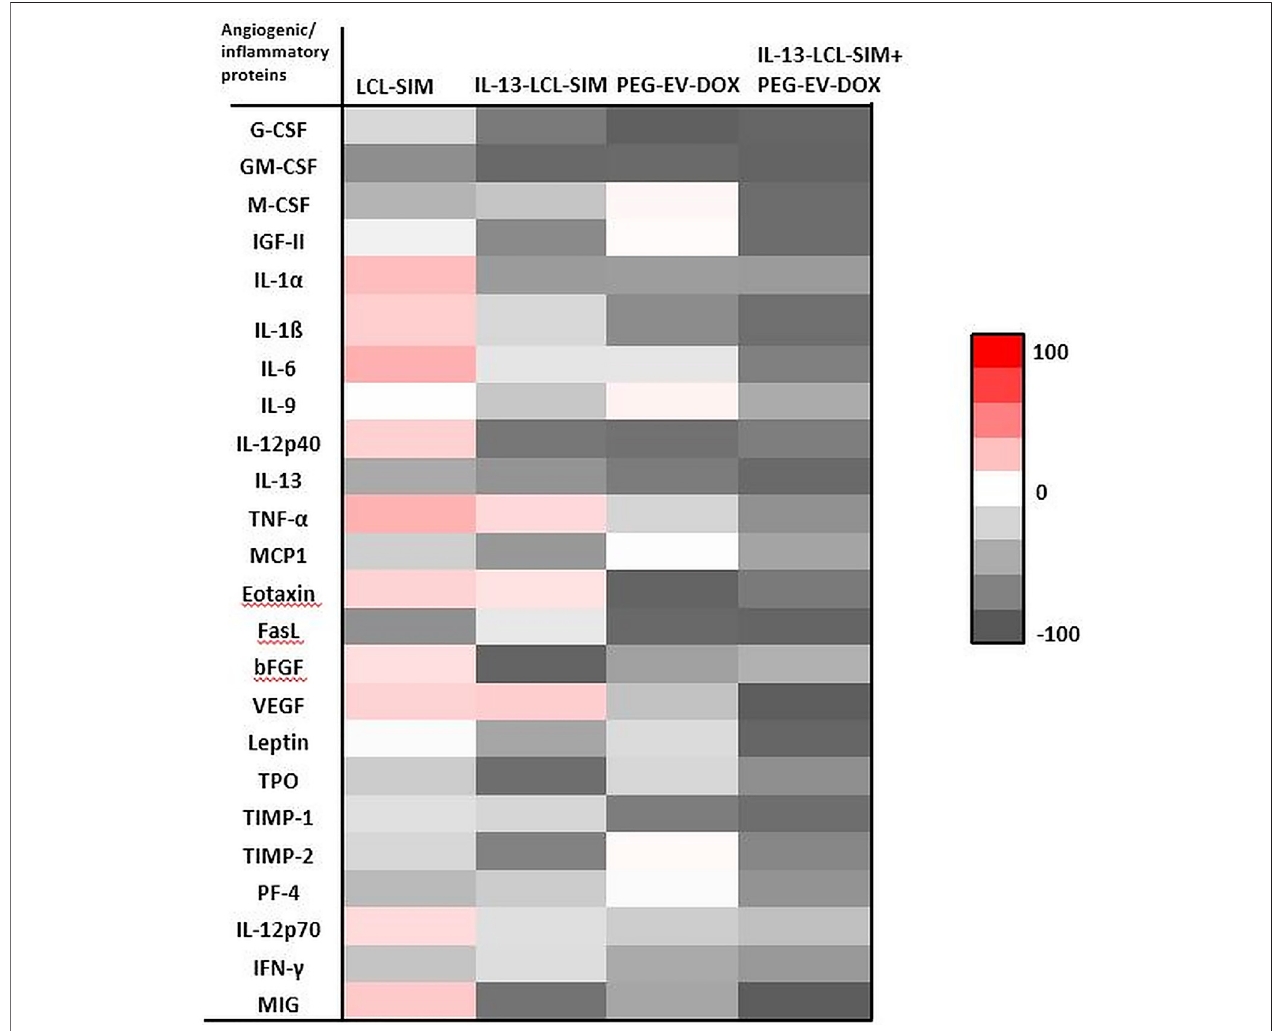
FIGURE4| Effectsofvarioustreatmentsonangiogenicprotein production inmelanoma tumors.Proteinlevels werecompared withthelevelsofthesame proteins in the control group. Data were expressed as average % of reduction ( – ) of protein levels ranging from 0% (white) to 100% (black) or stimulation (+) of production of proteins ranging from 0% (white) to + 100% (red) compared with the levels of the same proteins in the control group. Control, untreated group; IL-13-LCL-SIM, group treatedwith5 mg/kgIL-13-LCL-SIMondays7and10aftertumorcellinoculation;PEG-EV-DOX,grouptreatedwith2 mg/kgPEG-EV-DOXondays8and11after tumor cell inoculation; IL-13-LCL-SIM + PEG-EV-DOX, the group received the nano-formulations sequentially, IL-13-LCL-SIM 5 mg/kg on days 7 and 10, respectively, and PEG-EV-DOX 2 mg/kg on days 8 and 11 after tumor cell inoculation.